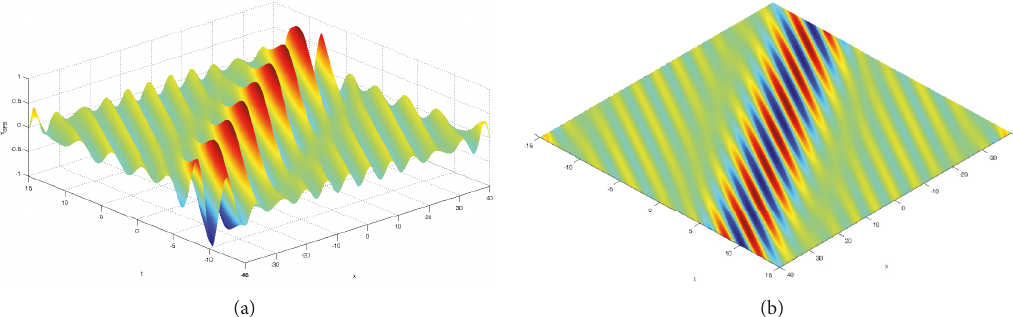
Figure 3: (a) Wave train profile and (b) wave contour of 𝜂